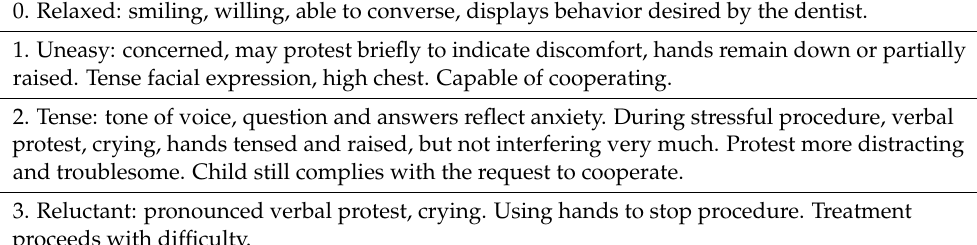
Table 1. Modified Venham